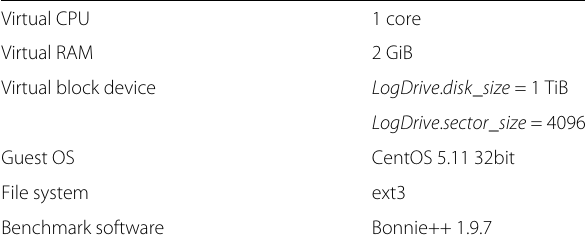
Table 4 Configuration of the virtual machines